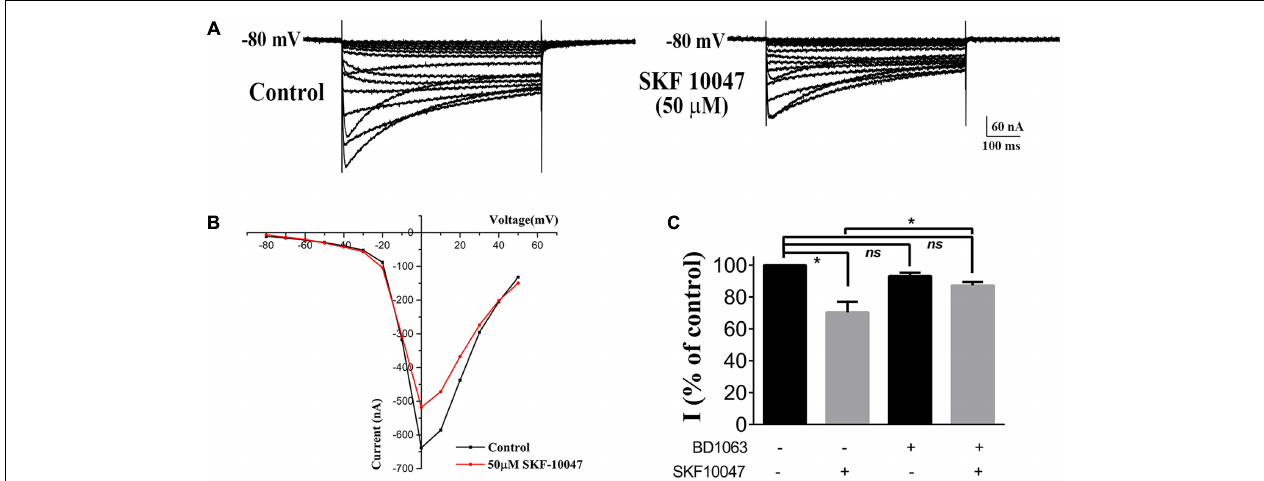
FIGURE 5 | Effect of sigma-1 receptor agonist and antagonist on N-type Ca 2 + channel. (A) Example trace of the inhibition on N-type Ca 2 + current induced by 50 µ M SKF-10047. The oocyte was injected with a cRNA ratio of sigma 1R: N-type Ca 2 + channel = 0.25:1. (B) I–V plot of the recorded N-type Ca 2 + current from the oocyte in (A) . (C) Summarized bar graph to present the effect of SFK-10047 (sigma-1 receptor agonist) and BD-1063 (sigma-1 receptor antagonist) on N-type Ca 2 + currents. Two-way ANOVA analysis, Mean ± SEM, ∗ p <